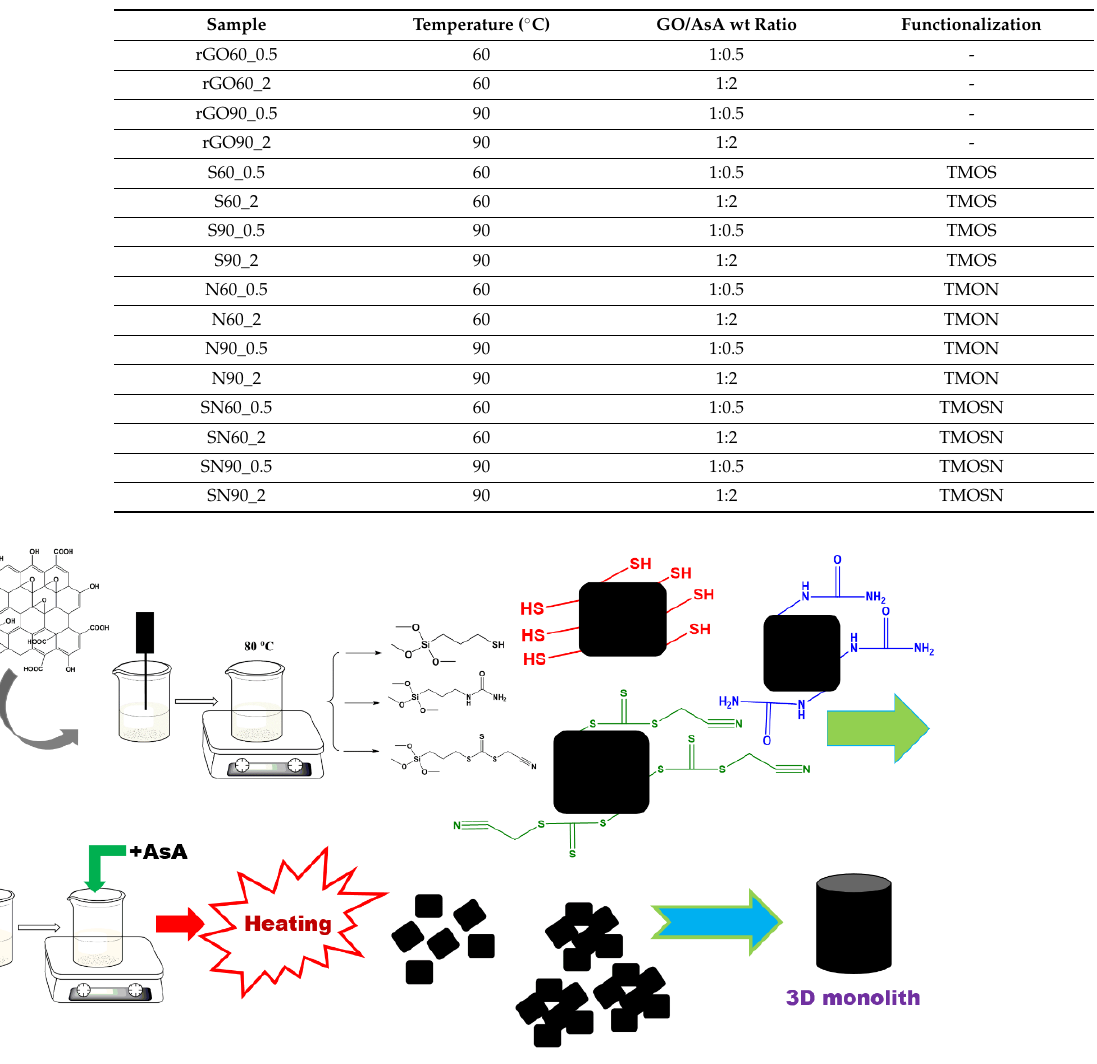
Table 1. Monolith abbreviations, synthesis conditions, and functionalization.